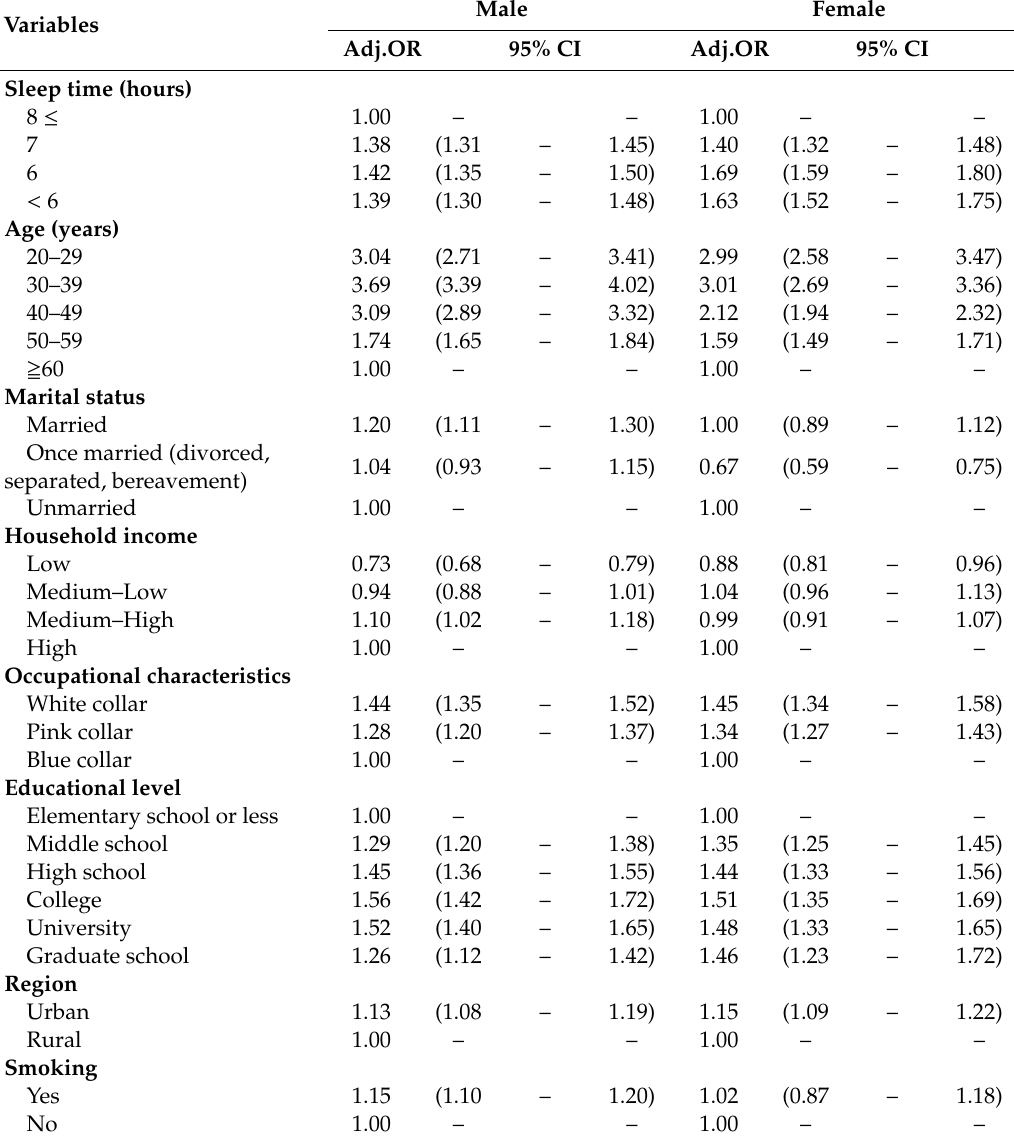
Table 2. Logistic regression analysis of the association between stress and sleep